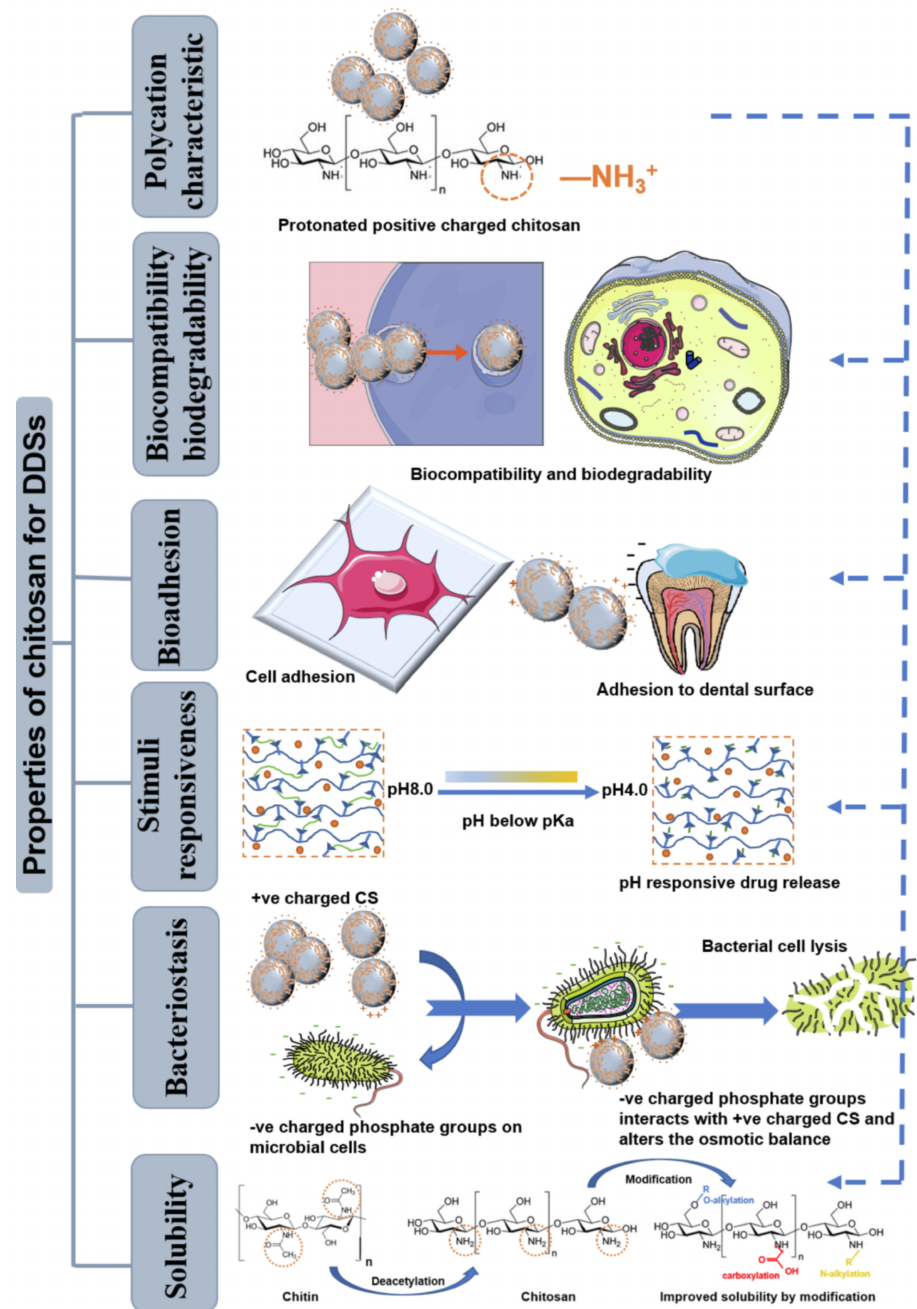
Figure 29. Characteristics and properties of chitosan as the best drug delivery agent. Reprinted from [85]. Copyright 2022 with permission from